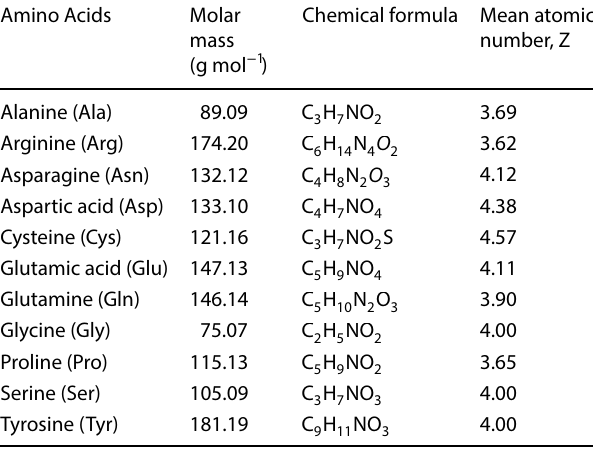
Table 1 Non-essential amino acids Amino